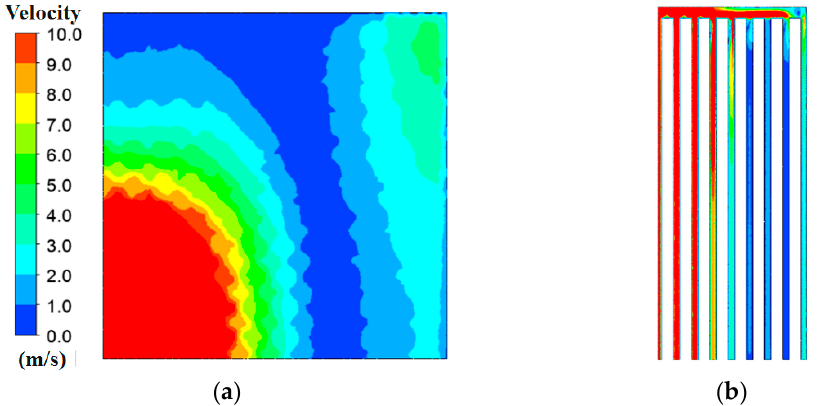
Figure 7. A quarter velocity profiles at cross-section and DF-PCHE channels for Δ L = 100 mm ( α = 1.81), ( a ) quarter velocity profiles at Δ L =100 mm ( α = 1.81), and ( b ) velocity distribution at PCHE channels.